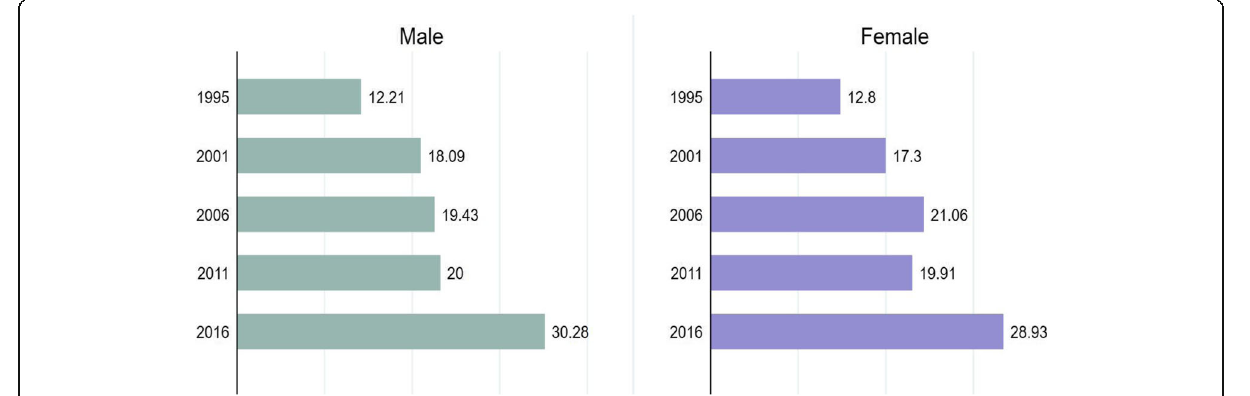
Fig. 2 Percentage of infants receiving treatment for fever/cough ( n = 14,334)